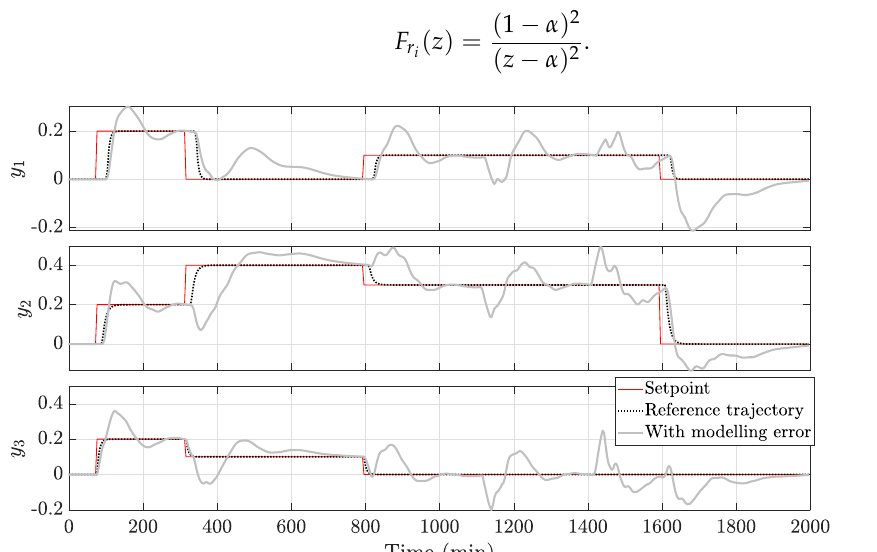
Figure 13. Case 1—Response of the HOF outputs to setpoint changes and disturbance rejections with uncertainties.